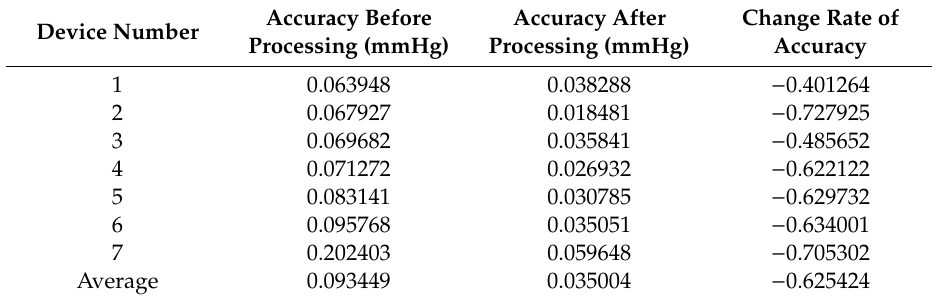
Table 1. Accuracy of pressure sensors before and after the processing treatment and their change